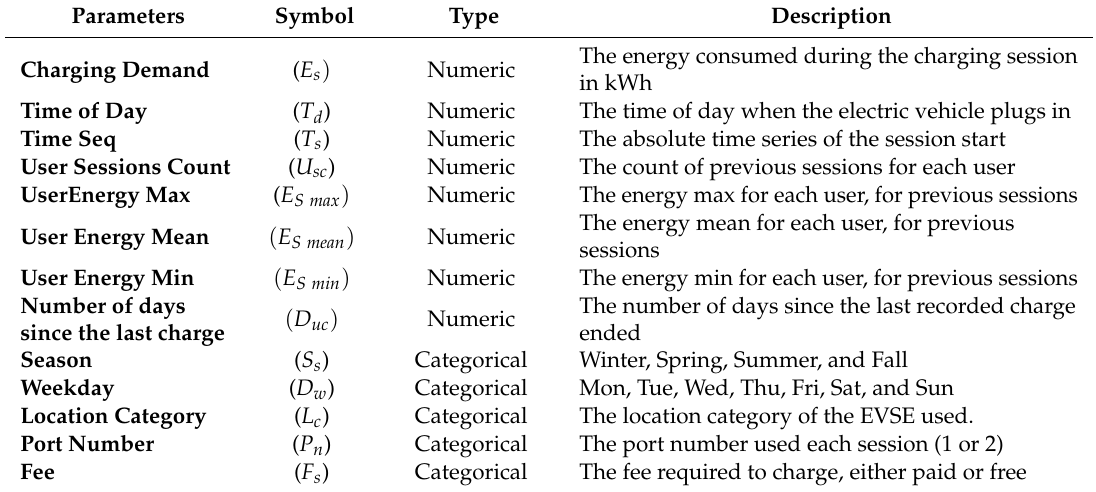
Table 2. Parameters of interest for each charging